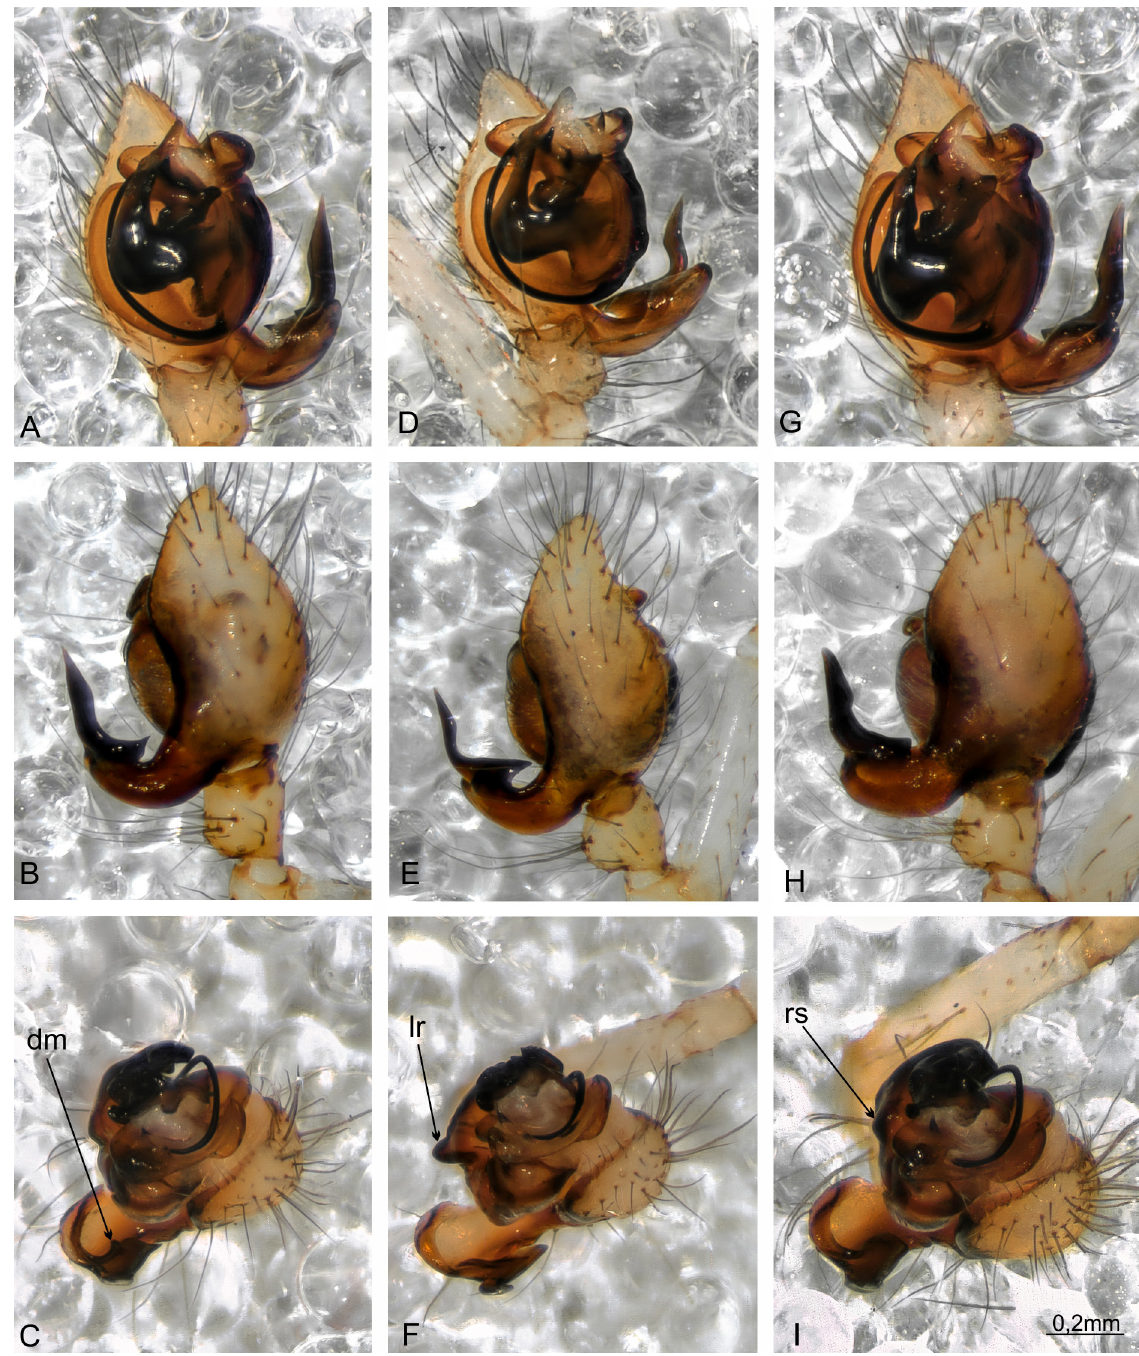
Fig 3. Male bulbus. A–C. Krytponesticus deelemanae gen. et sp. nov. D–F. K. fagei (Kratochvíl, 1933). G–I . K. arenstorffi (Kulczyński, 1914). A , D , G . Ventral view. B , E , H . Dorsal view. C , F , I . Apical view. The scale (shown on I) is the same for all